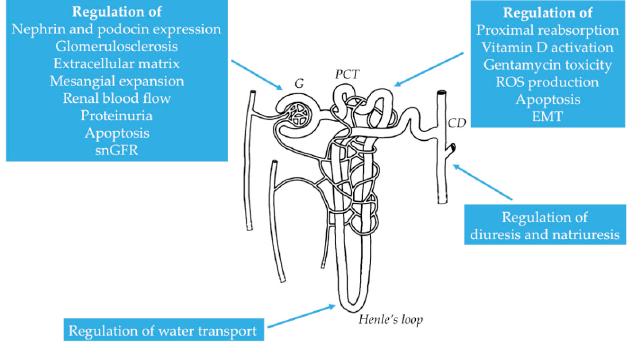
Figure 2. Distinctive roles of NMDAR in various segments of the nephron. G: glomerulus; PCT: proximal convoluted tubule; CD: collecting duct; snGFR: single nephron glomerular filtration rate; EMT: epithelial-mesenchymal transition; ROS: reactive oxygen species.